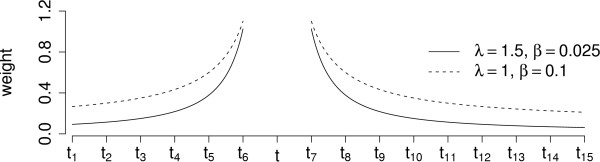
A weighting example. Here is an example of a context (t1,..., t16). The term t is the name to be disambiguated. Figure illustrates the weights of the context words t1,..., t16 with two different parameter value pairs of λ and β. The weight values are represented as a continuous function, although they take discrete values. The parameter combination λ = 1.5 and β = 0.025 yields the best performance when using the linear kernel.